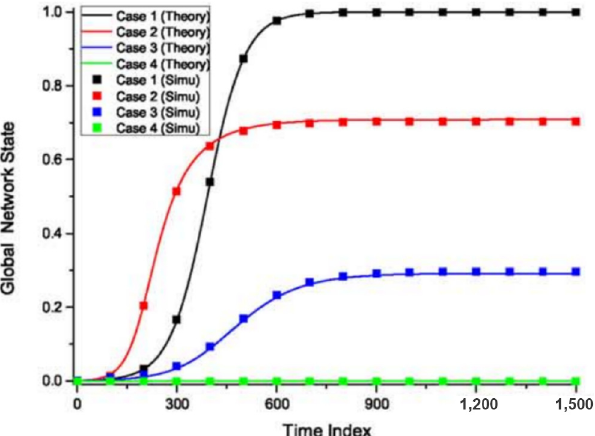
Figure 3. Simulation results for synthetic